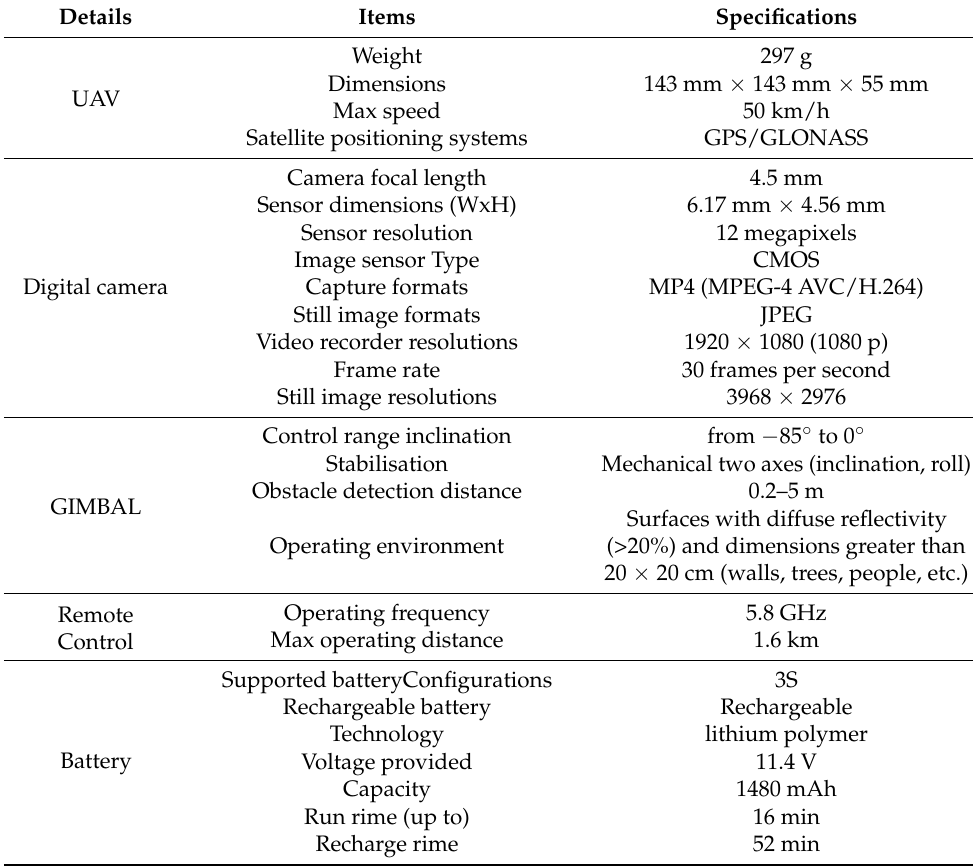
Table 2. Specifications of the unmanned aerial vehicle (UAV) DJI™